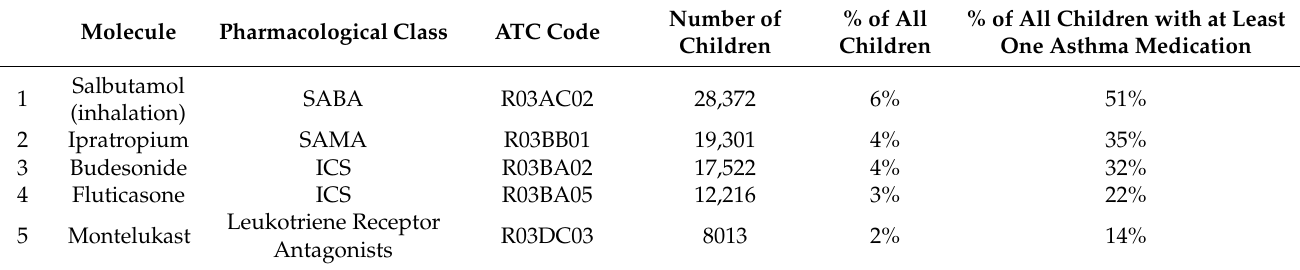
Table 2. Top five most dispensed asthma medications in